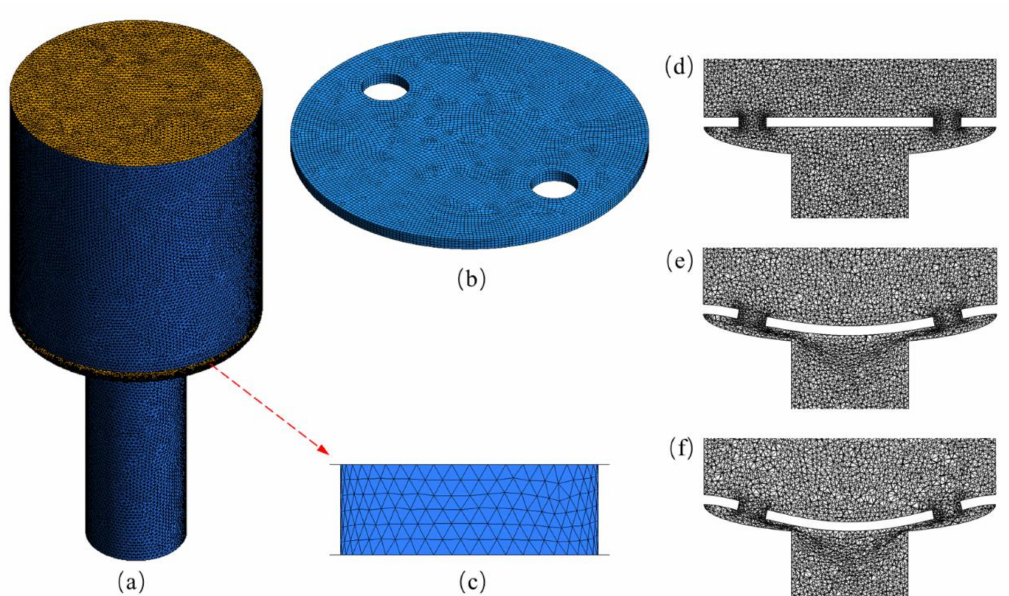
Figure 4. ( a ) Fluid domain mesh, ( b ) solid domain mesh, ( c ) refined mesh of microhole, ( d ) initial state without fluid of MPV, ( e , f ) mesh moving process of the fluid domain with the membrane